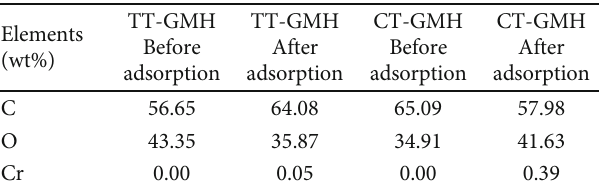
Figure 2: SEM-EDX analysis of (a, b) TT-GMH before adsorption, (c, d) TT-GMH after adsorption, (e, f) CT-GMH before adsorption, and (g, h) CT-GMH after adsorption. Table 1: Chemical composition of TT-GMH and CT-GMH before and after adsorption of